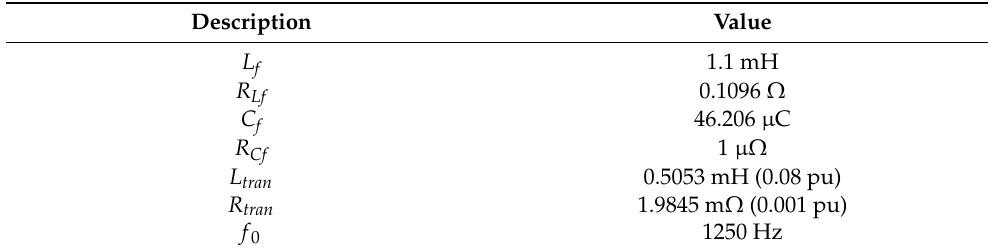
Table 5. The LCL filter elements.